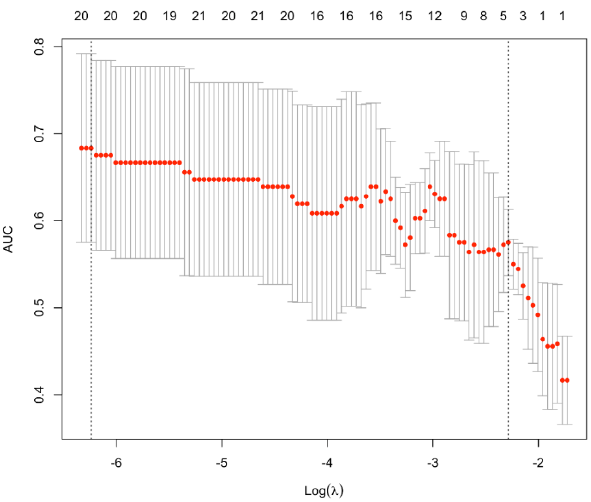
Figure 2. Accuracy of the predictive algorithm that uses cutaneous lipids to predict the water type consumed. The line composed by red dots depicts the average accuracy of the presented predictive algorithm. AUC: Area under the ROC Curve